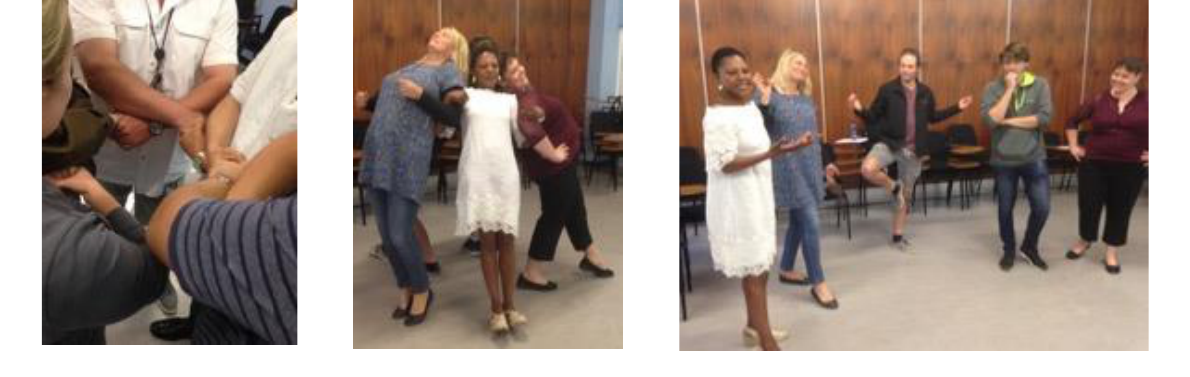
Figure 16 : ‘Identity’ body